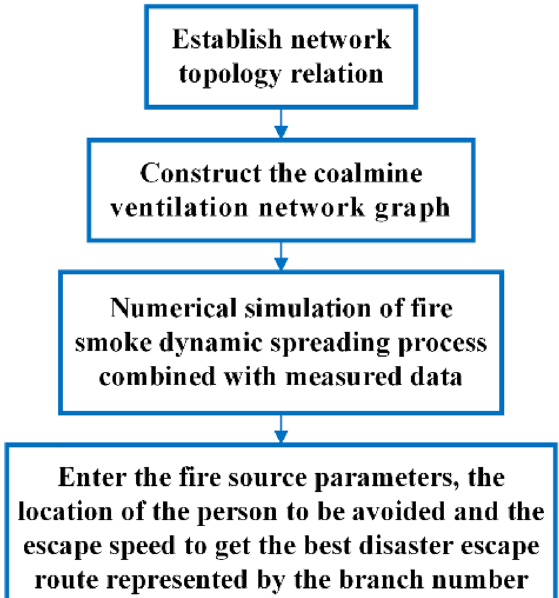
Figure 3. Modeling process of the best disaster escape route.